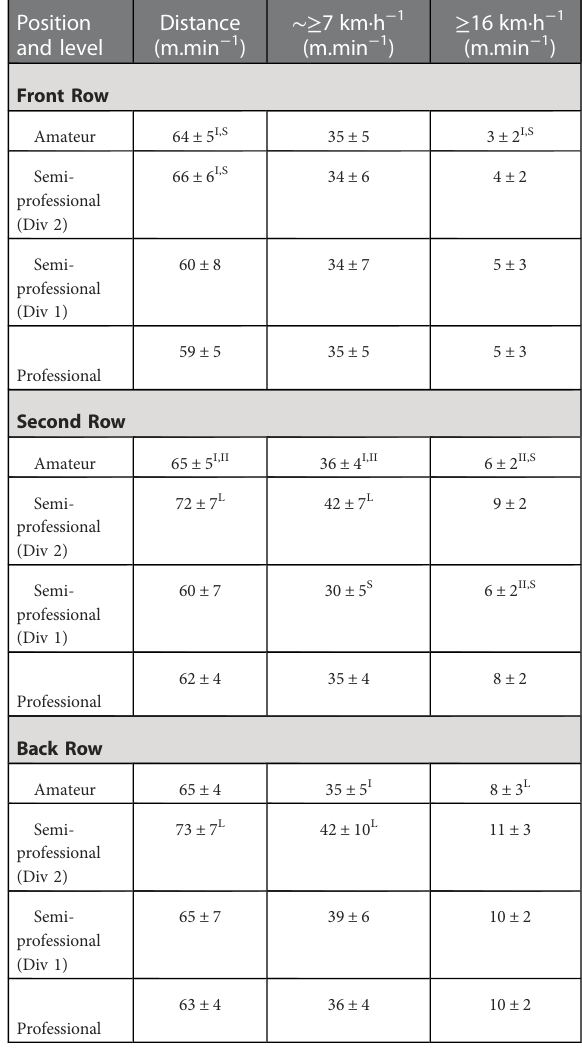
TABLE 4 Relative distance measures (mean±SD) for back positions in all levels of rugby competition. Position and